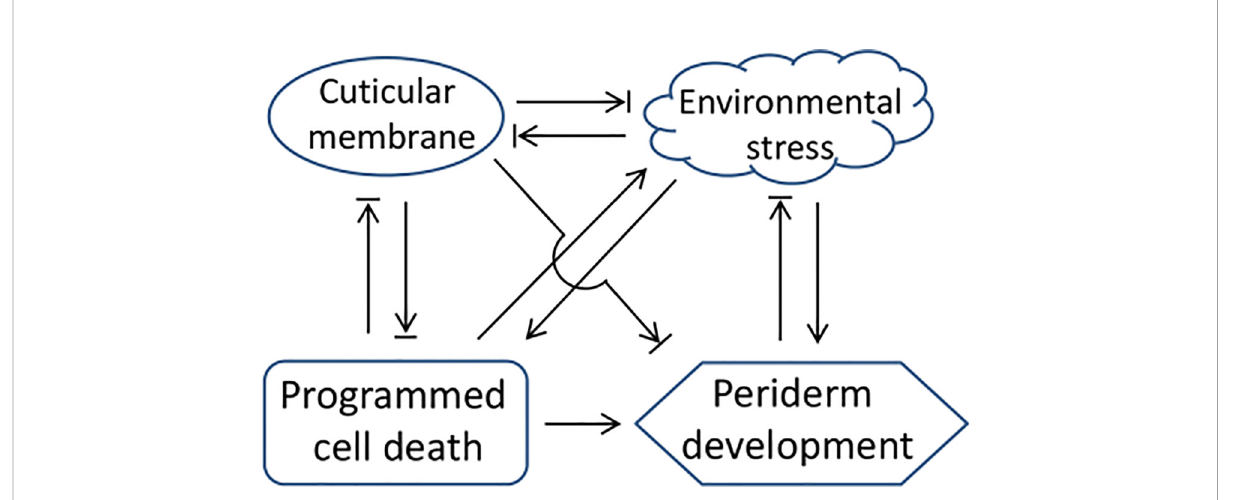
FIGURE 5 A network of the regulatory factors and periderm development. The arrow and termination arrow symbols indicate that one side of the link promotes or inhibits the development of the other